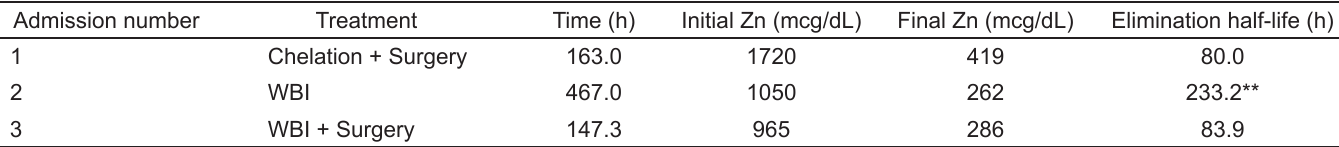
Table 1. Serum laboratory values on each of the three visits for zinc